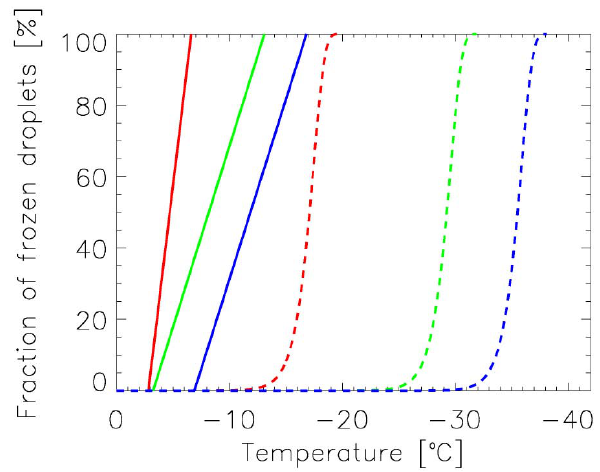
Fig. 1. Contact freezing frozen fractions (full lines) and immersion freezing frozen fractions (dashed lines) for a droplet radius of 10µm of bacteria (red), montmorillonite (green) and kaolinite (blue); from experimental data. Adapted from Lohmann and Diehl